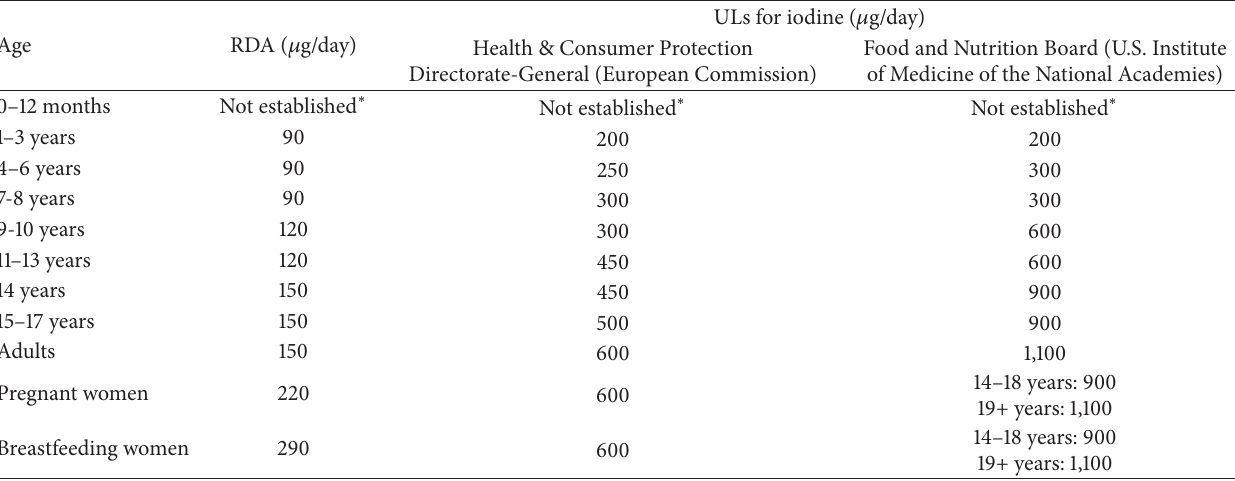
Table 1: RDA and ULs for iodine according to the European Commission [4] and to the U.S. Institute of Medicine of the National Academies